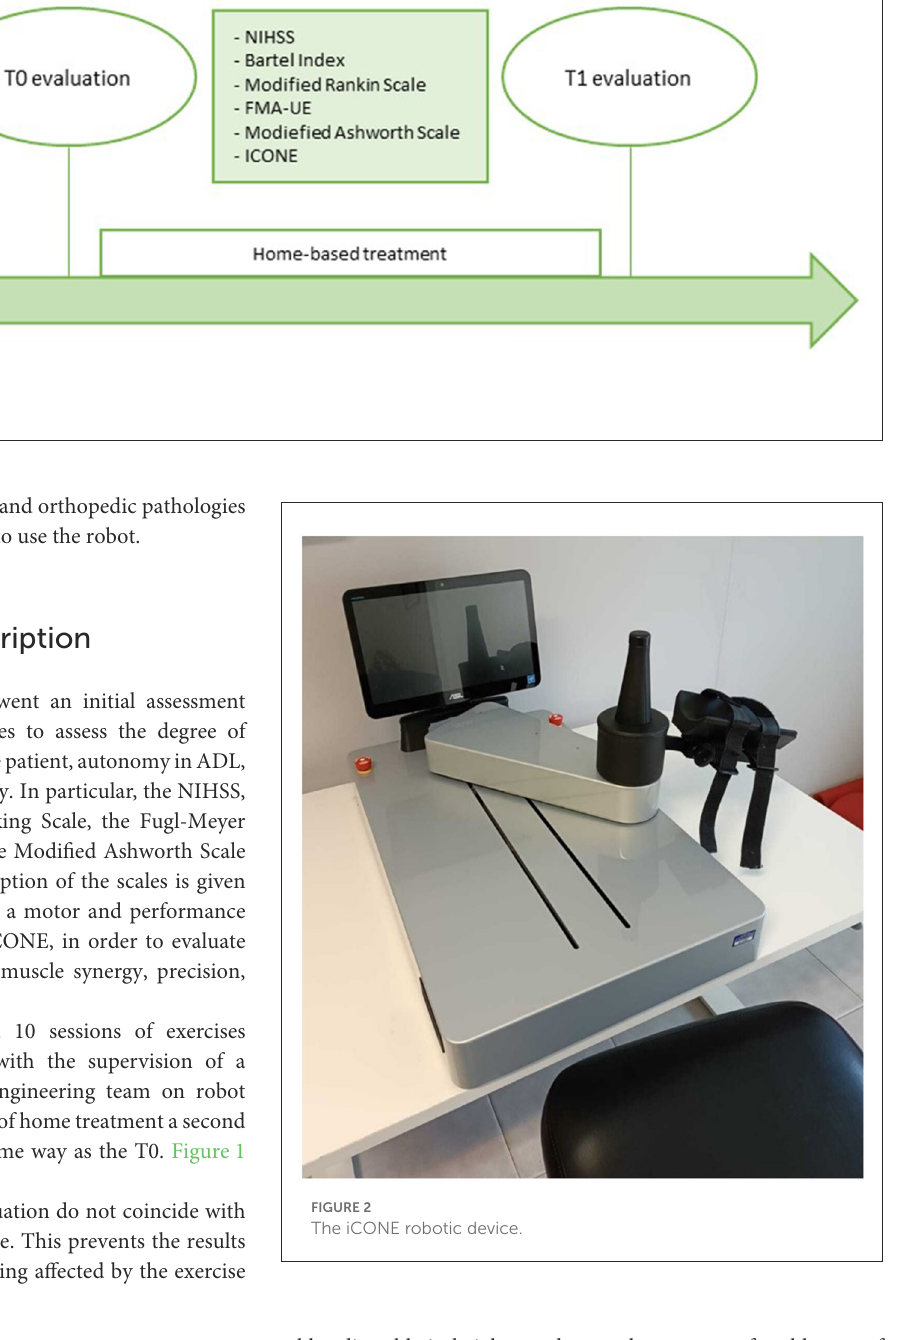
table adjustable in height to adapt to the most comfortable seat of the